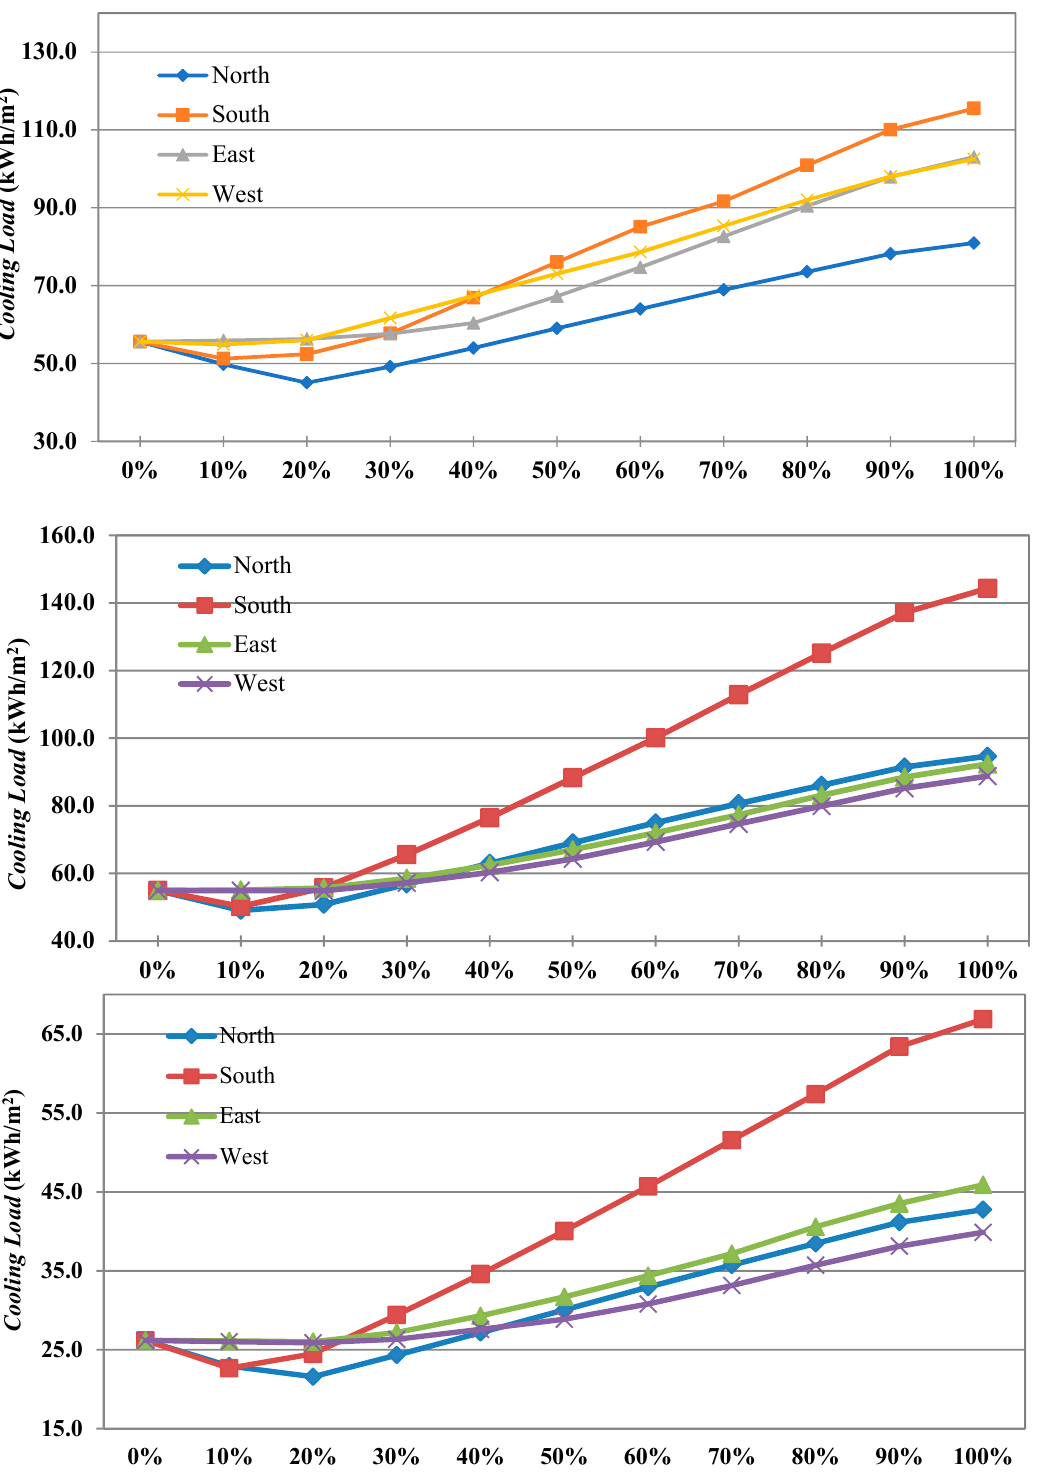
Figure 5. The amount of annual cooling load of the building with different percentages of windows at different facades for Bushehr (upper), Shiraz (middle), and Tabriz (below), Iran.